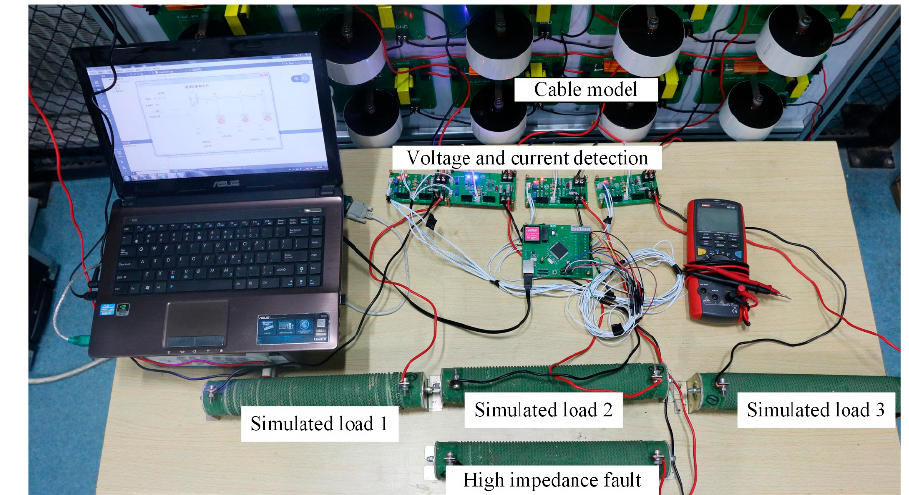
Figure 15. Fault detection experimental platform.